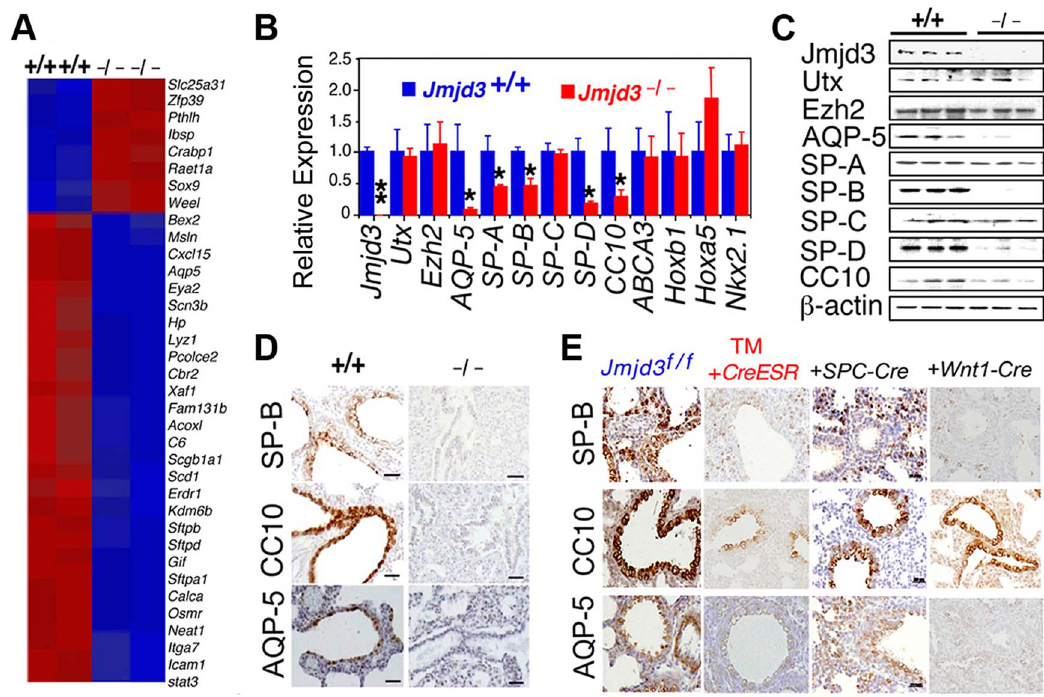
Figure 4. Jmjd3 regulates the expression of genetic markers of lung development. ( A ) Microarray analysis showing representative genes that were differentially expressed between WT and Jmjd3 2 / 2 lung tissues at E17.5. Red, upregulated genes; blue, downregulated genes. ( B ) qPCR was done to validate the expression of selected genes in WT and Jmjd3 2 / 2 lung tissues. Gene expression levels were normalized to b -actin. Gene expression levels in WT lung tissue were defined as 1. Data are presented as the mean 6 SD. * P , 0.05 and ** P , 0.001 (Student’s t test). ( C ) Immunoblot analysis of the protein expression of selected genes in the lung tissues of Jmjd3 + / + and Jmjd3 2 / 2 embryos at E19.5. ( D ) Immunohistocytochemical staining of SP-B, CC10, and AQP-5 protein expression in the lung tissues of Jmjd3 + / + and Jmjd3 2 / 2 embryos at E19.5. Data shown are representative of three independent experiments. Bar=50 m m. ( E ) Immunohistocytochemical staining of SP-B, CC10, and AQP-5 expression in the lungs of Jmjd3 f/f , Jmjd3 f/f :CreESR /TM, Jmjd3 f/f :SPC-Cre , and Jmjd3 f/f :Wnt1-Cre mice. Data shown are representative of three independent experiments. Bar=50 m m.